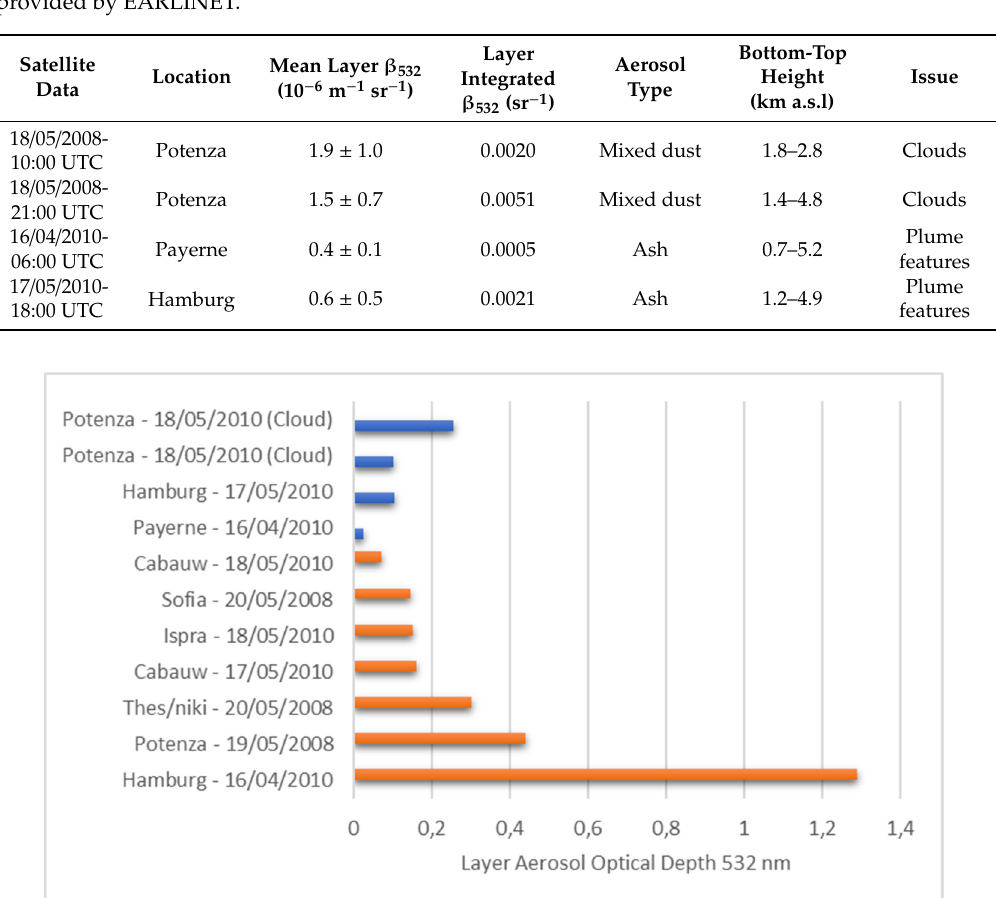
Table 2. Ash / dust layers reported by EARLINET and undetected by RST ash / dust algorithms. The mean-layer backscatter coe ffi cient ( β 532) at 532 nm along with the standard deviation, the layer integrated backscatter coe ffi cient at 532 nm, the aerosol type and the bottom-top layer height are provided by EARLINET.